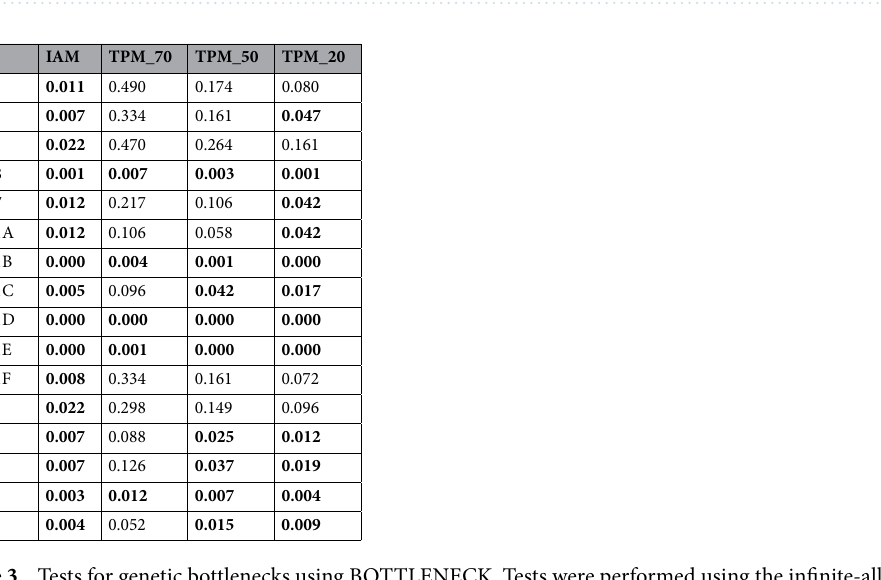
Figure 5. Discriminant analysis of principal components (DAPC) scatter plots based on 16 STR-markers and all individuals for brown trout ( Salmo trutta ) in zone I, including the temporal sample I2007.